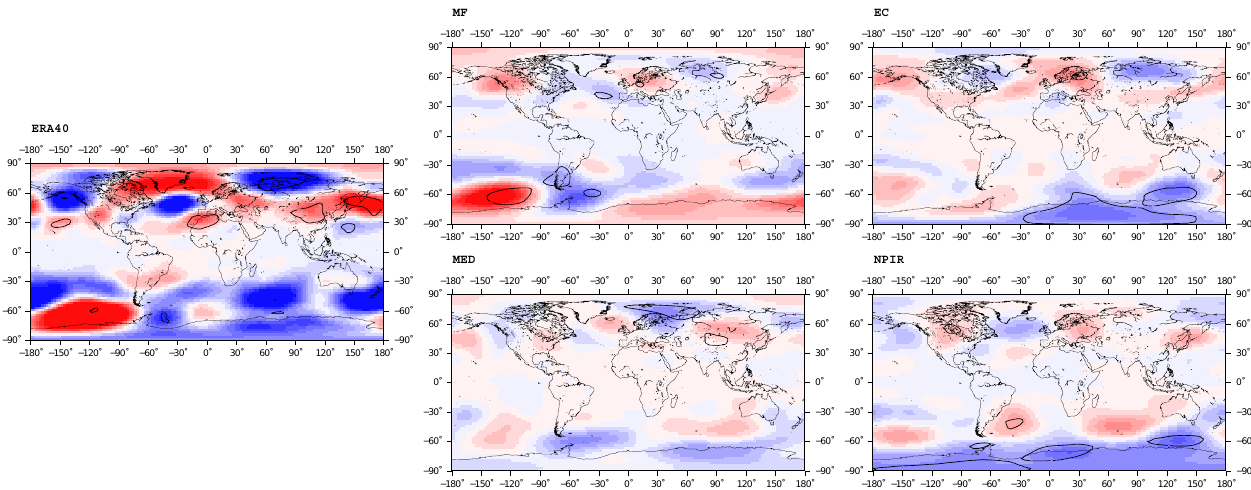
Fig. 1. Z500 anomaly composites (red: + , blue: − ) built from averaging Z500 anomalies over the years characterised by a frequency of HPE occurrence being in the upper 17% of the distribution; from left to right and top to bottom ERA40, MF, EC, MED, and NPIR. Contour interval 2m. The statistically significant patterns are delimited with black solid lines, from a Student confidence